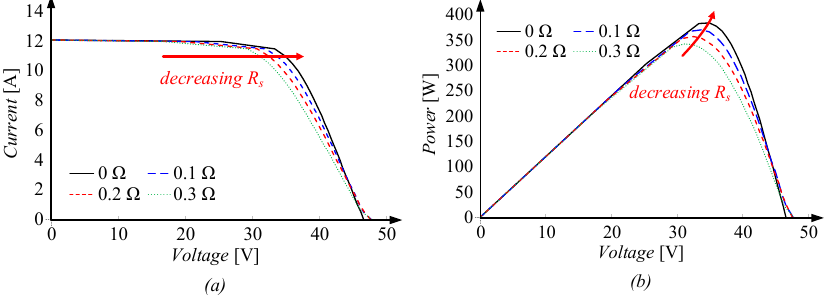
Figure 15. Block diagram for the experimental process with a series of multiple connected PVEs.